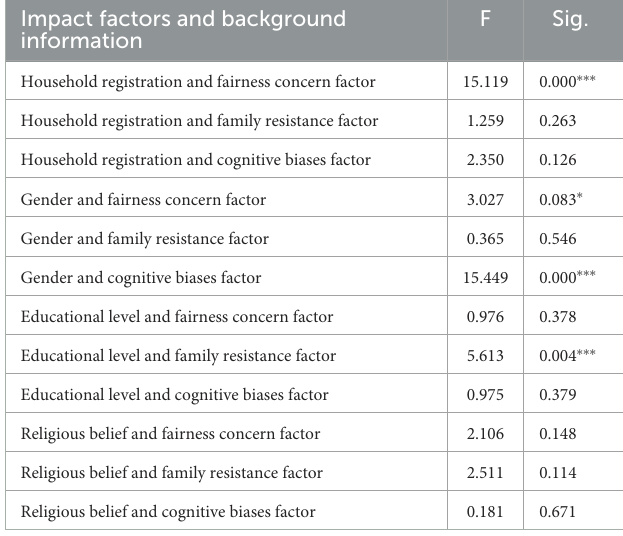
TABLE 14 ANOVA (unwilling to be an organ